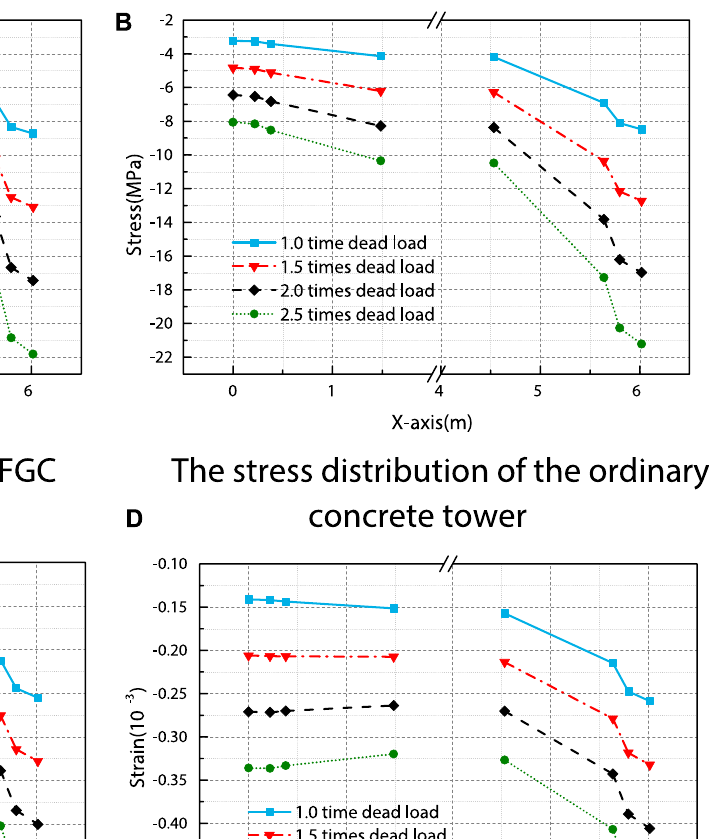
Frontiers in Materials |